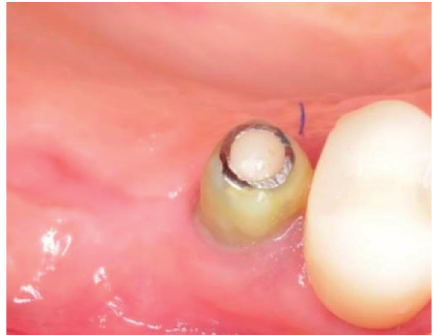
Figure 19: Condition of the soft tissues after suture removal on the 10th day.